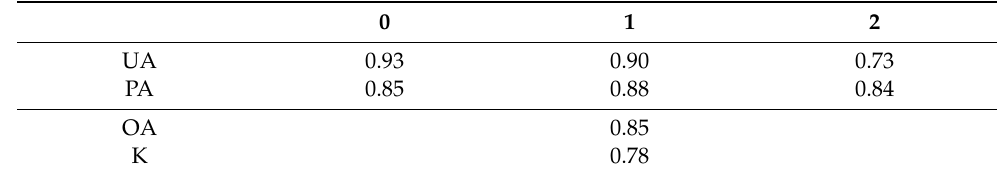
Table 6. Overall accuracy for kNN classification.